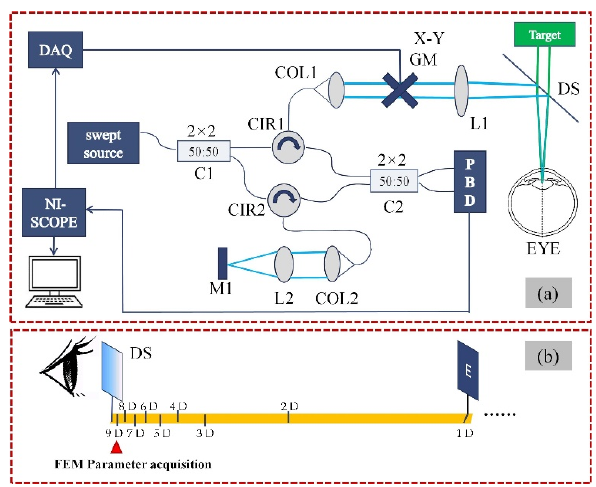
Figure 1. Schematic diagram of the SS ‐ OCT system ( a ) and the acquisition of finite element model parameter ( b ). L1, L2: lens; C1, C2: fiber coupler; PBD: balanced photodetector; M1: mirror; COL1, COL2: collimator; CIR1, CIR2: circulator; GM: galvanometric mirror. DS: dichroic mirror.